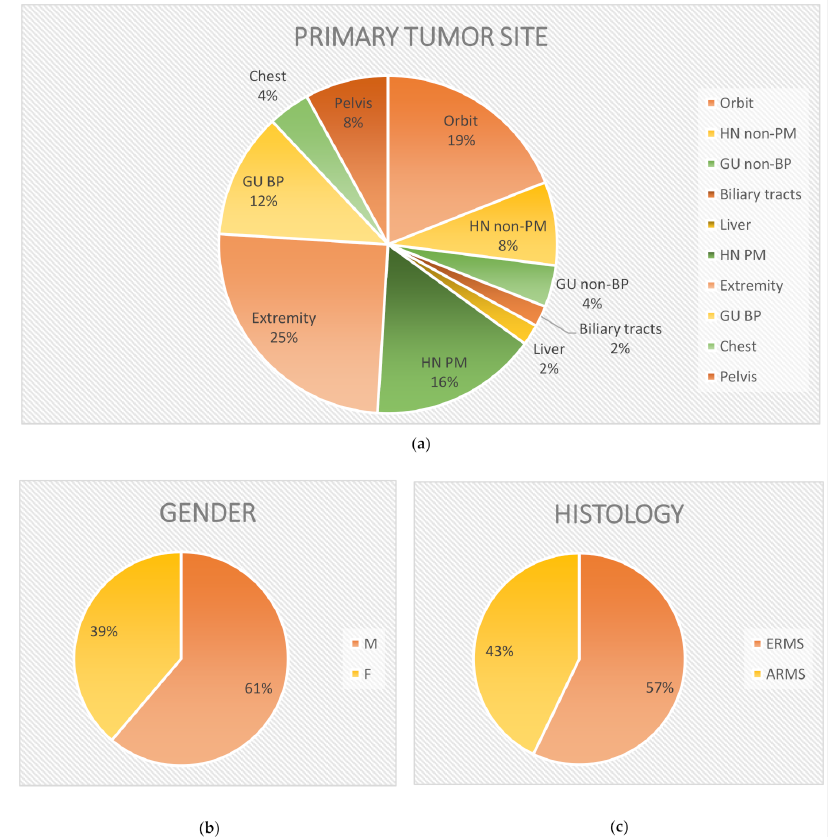
Figure 1. Diversification of study group in terms of primary tumor site location ( a ), sex ( b ), and histopathology ( c ). ( a ) Abbreviations: GU BP, genitourinary tract—bladder and/or prostate; GU non-BP genitourinary tract with the exception of the bladder and prostate; HN PM, head and neck— parameningeal region; HN non-PM, head and neck with the exception of the parameningeal region. ( b ) Abbreviations: M, male; F